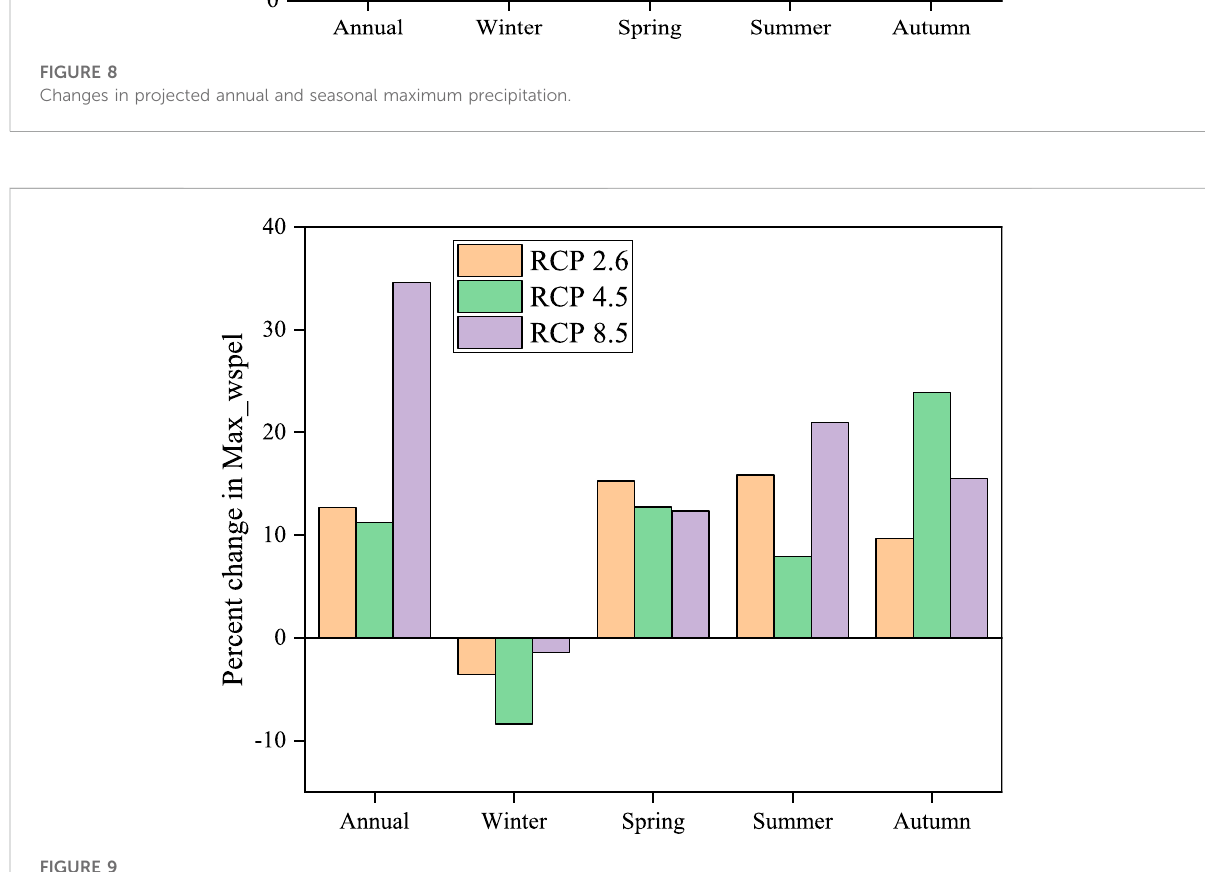
FIGURE 9 Percent change in maximum wet spell